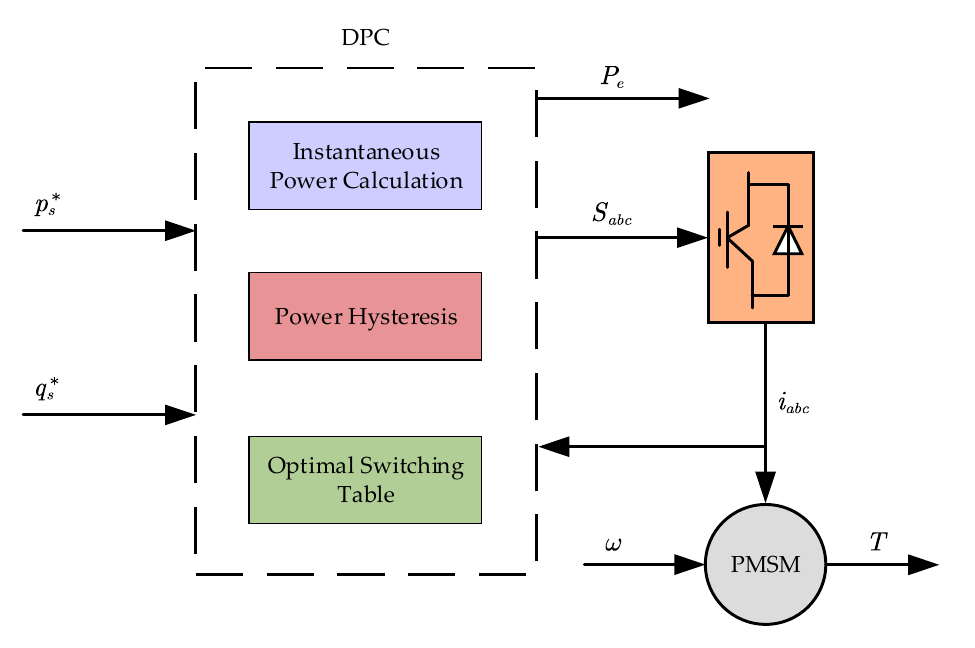
Figure 4. DPC control scheme for PMSM.